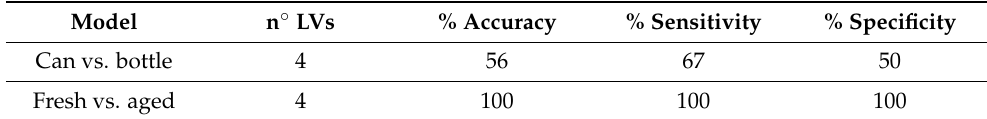
Table 4. Results of the PLS-DA models can vs. bottle and fresh vs. aged beer. Model